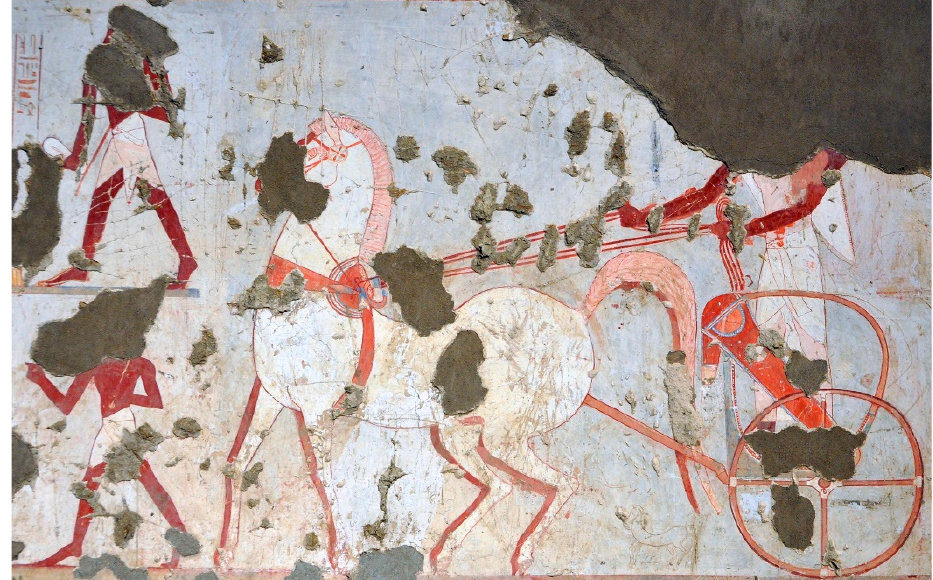
Figure 2. Horses and chariot from the tomb of Amenhotep Sise, TT75. Photo: Alexis den Doncker, © Université de Liège.